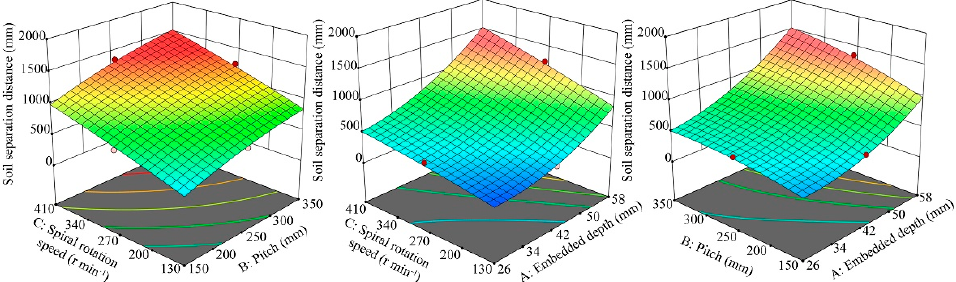
Figure 13. Response surface analysis of the relationship between test factors and separation distance.